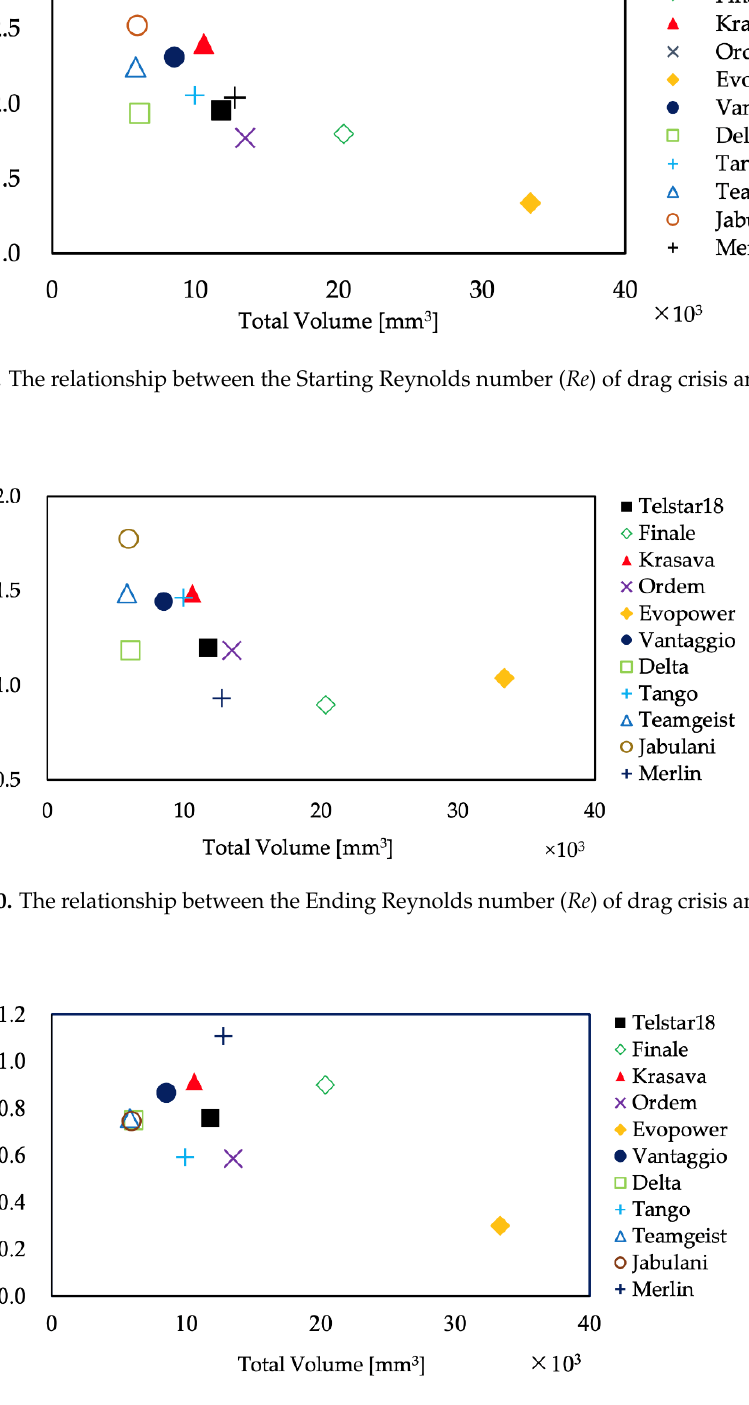
Figure 12. The relationship between groove volume and drag coefficient ( C D ) in the subcritical regions.